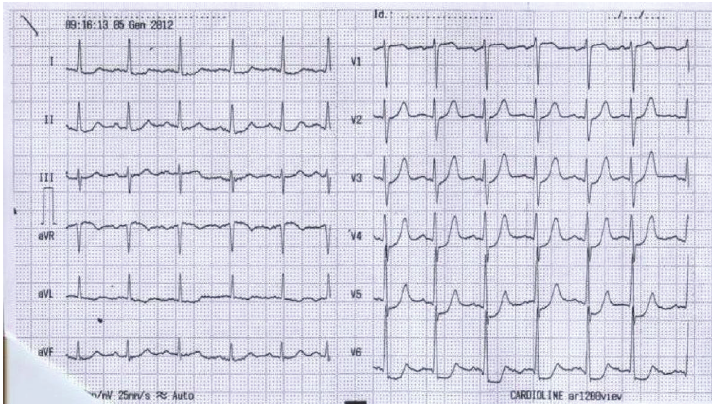
Figure 2: Surface ECG performed at the high-dose dipyridamole during stress echocardiography, showing a clear depression of the antero- septal ST segment. At the same time the patient referred angina